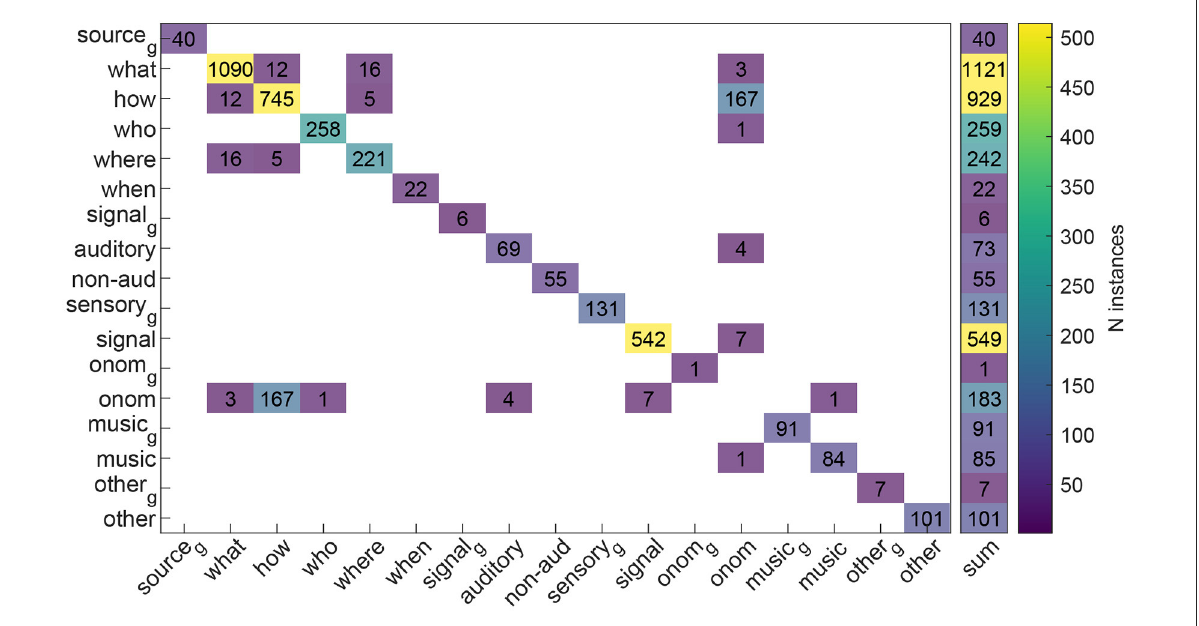
FIGURE3 Co-occurrence of sound-descriptor word-by-word classifications across all considered knowledge organization systems. Off-diagonal values indicate words classified, simultaneously in more than one descriptor class, whereas diagonal values indicate word classifications attributed to one single class. The subscript g denotes the generic descriptor classes (e.g., “sound source,” “audio signal”); non-aud, non-auditory; onom,